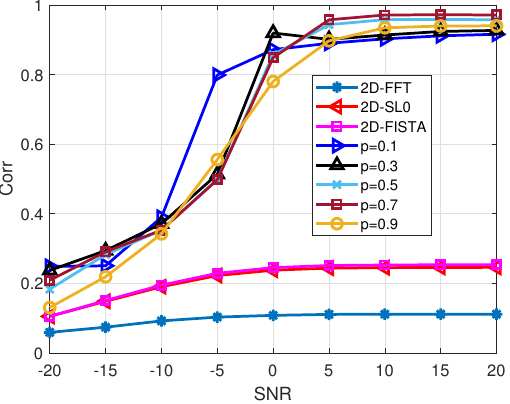
Figure 5. The relationship between the SNR and Corr.